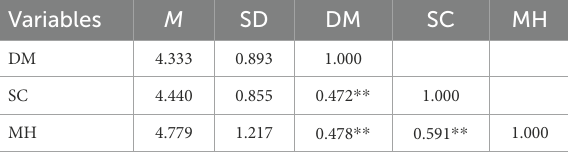
TABLE 2 Correlation analysis of variables.